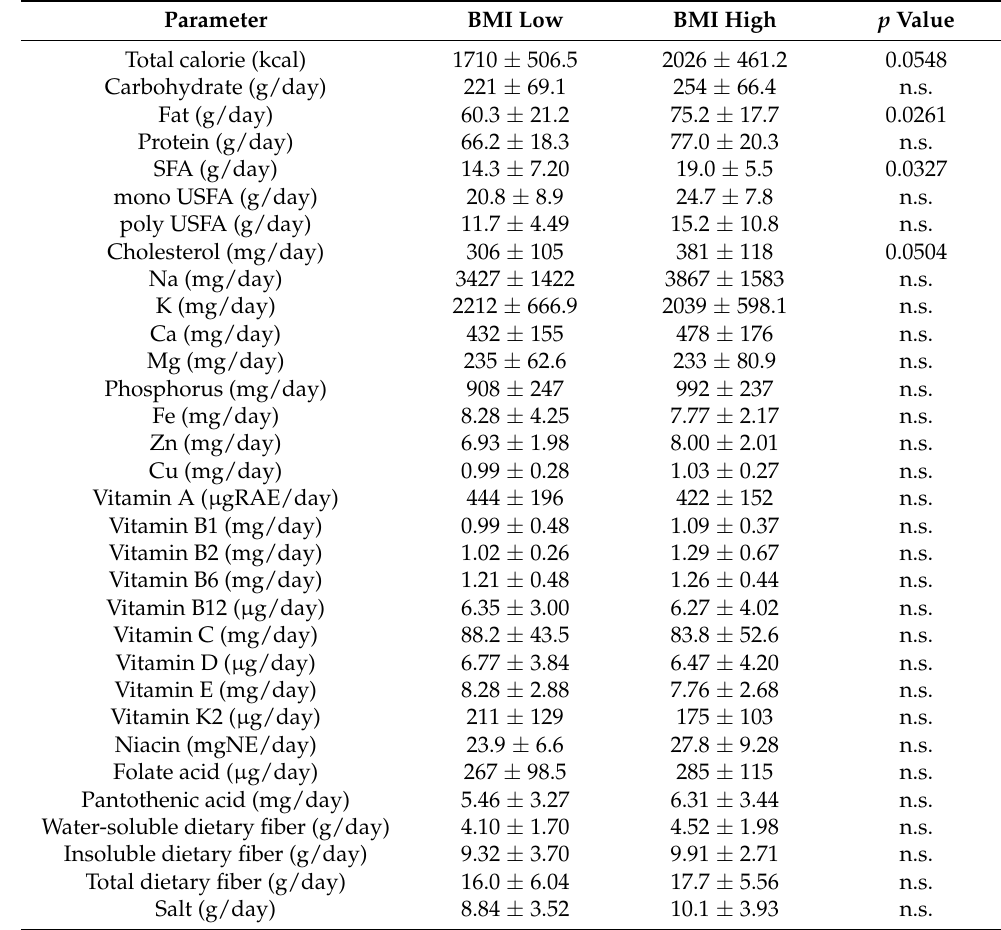
Table 7. Comparison of nutrient intake data (BMI Low group, BMI High